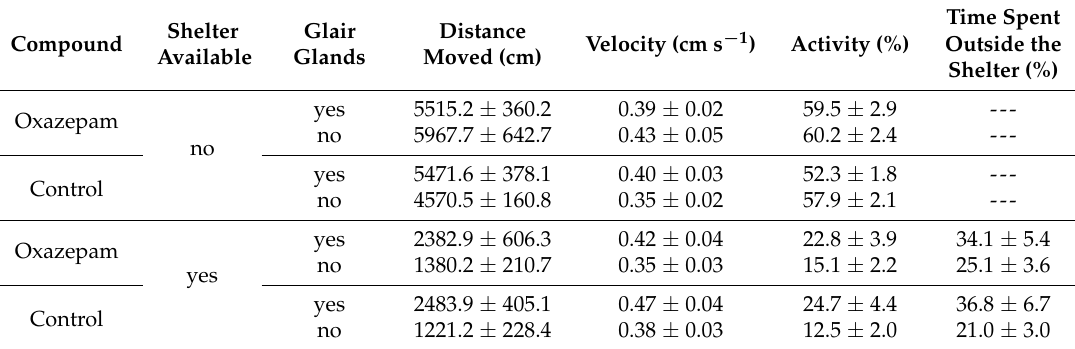
Table 6. The values of the distance moved, velocity, activity, and time spent outside the shelter in crayfish exposed to oxazepam and in control crayfish in accordance with the presence of glair glands, in set-ups with and without available shelter. Data are shown as mean ± standard deviation.